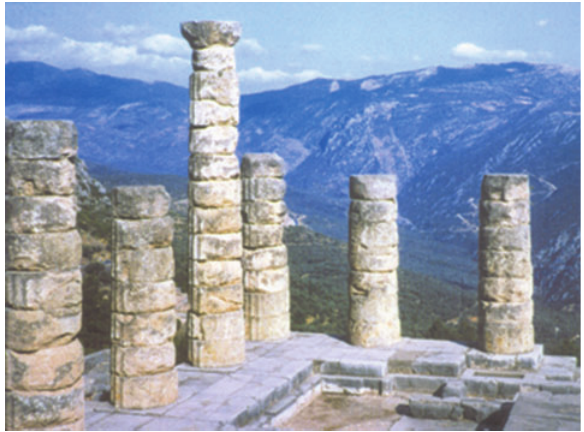
Figure 5 The temple of Apollo (Delphi, Greece). The surfaces of the limestone columns have been left as preserved. The extensive damage of the one side of the columns is to be noted contrary to the other side, which is relatively well